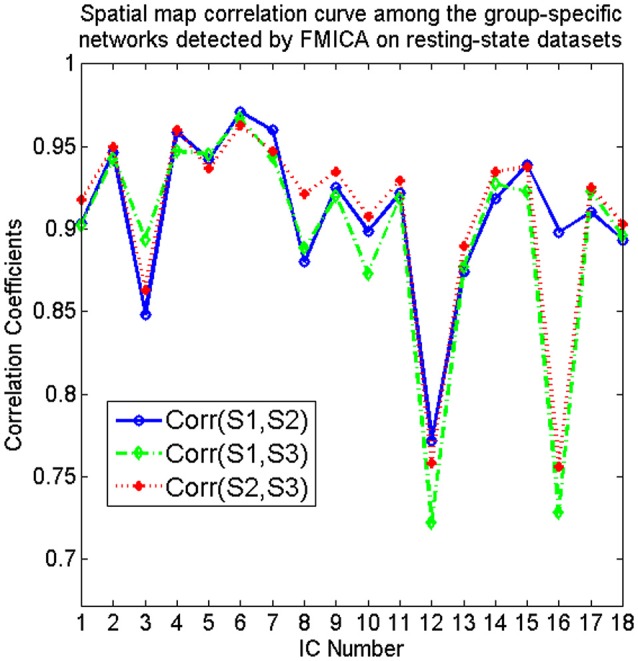
The spatial map correlation curves among the correspondingly intragroup-specific intrinsic BFNs identified by FMICA from the first (S1), second (S2), and third (S3) session of resting-state datasets, respectively.